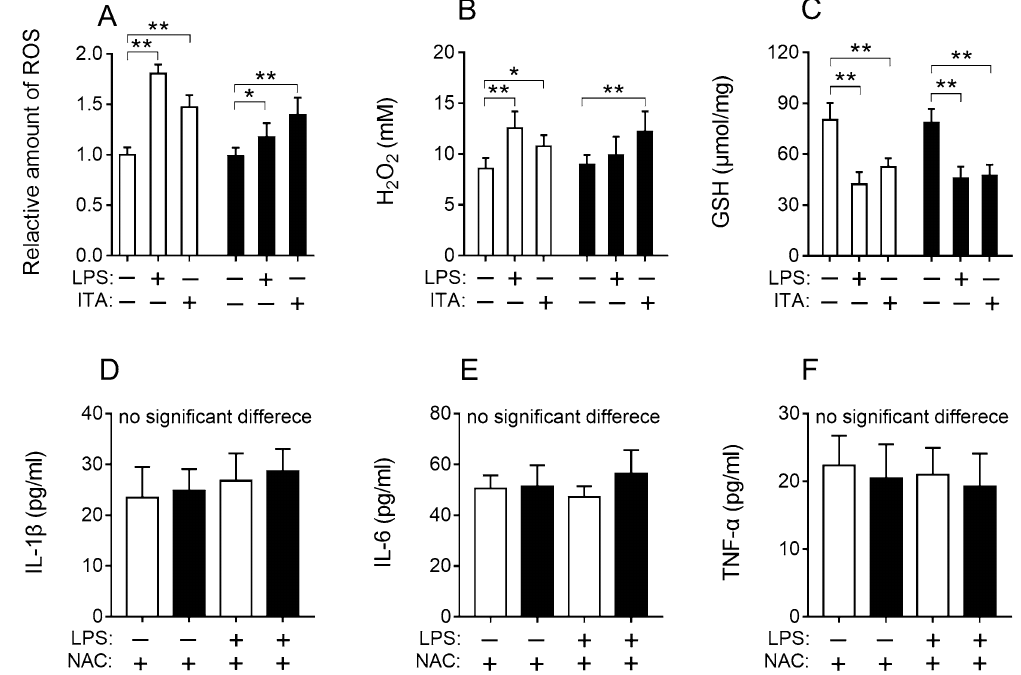
Figure 2. Results of ROS level in cell ( A ), H 2 O 2 in cell medium ( B ) and GSH level ( C ) in cell lysate. The levels of IL-1β ( D ), IL-6( E ), TNF-α ( F ) in cell culture medium from RAW264.7 and RAW264.7-IRG1KO with different treatments (24 h). White bar, RAW264.7; black bar, RAW264.7-IRG1KO. LPS, lipopolysaccharide; ITA, itaconic acid; NAC, N -acetyl-L-cysteine. Relative ROS amount in cells with different treatments was normalized to RAW264.7 control and represents the fold change. Values represent the mean ± S.E.M. *, p < 0.05; **, p <